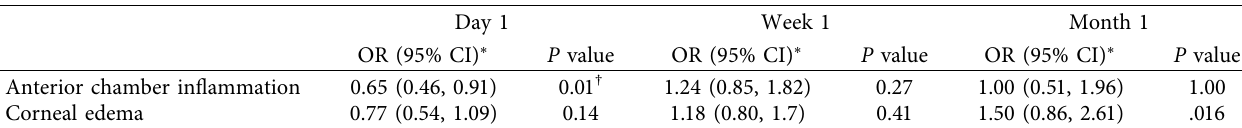
Table 4: Anterior chamber inflammation and corneal edema comparison between Tri-Moxi and Dex-Moxi-Ketor groups at different time